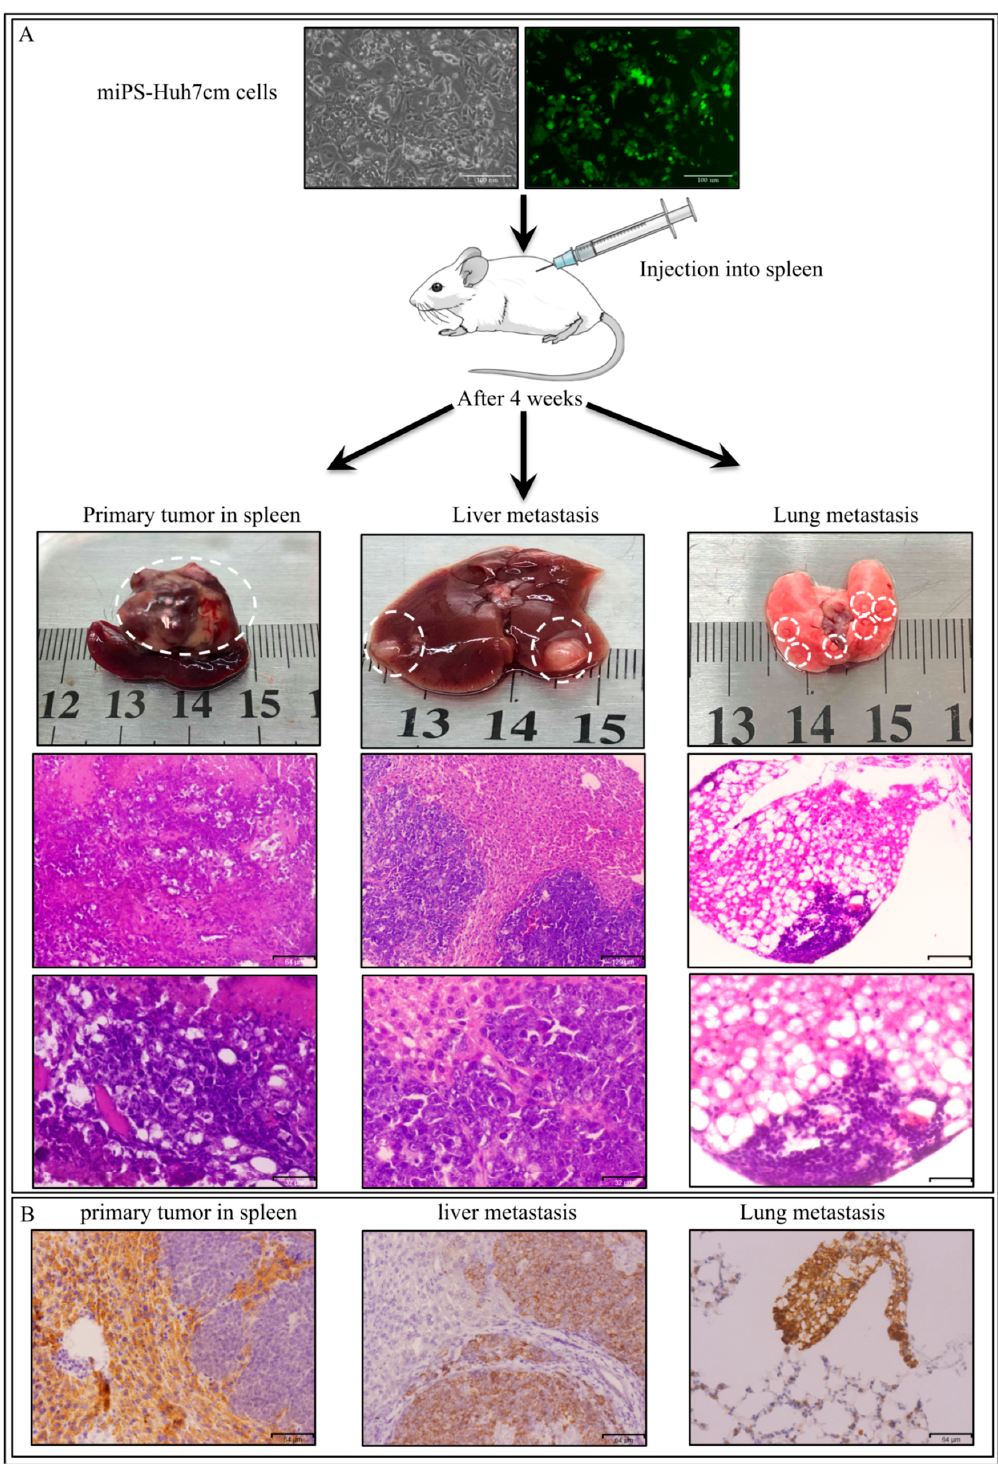
Figure 6. ( A ) Representative scheme of intrasplenic transplantation of miPS-Huh7cm cells and histological examination of derived tumors in different tissues. The results showed tumor formation in spleen, a liver metastasized tumor and lung-metastatic nodules. Scale bars represent 129 μ m and 32 μ m. ( B ) Immunohistochemistry of derived tumors against GFP which confirmed that miPS-Huh7cm cells were metastatic cells. Scale bars represent 64 μ m.